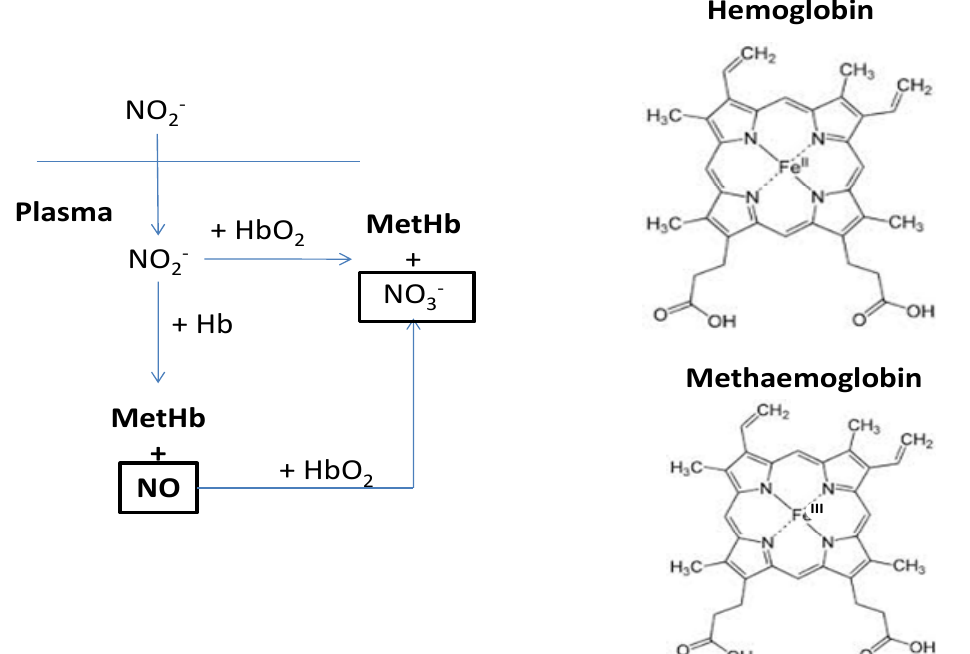
) with formation of MetHb and NO 2 − 3